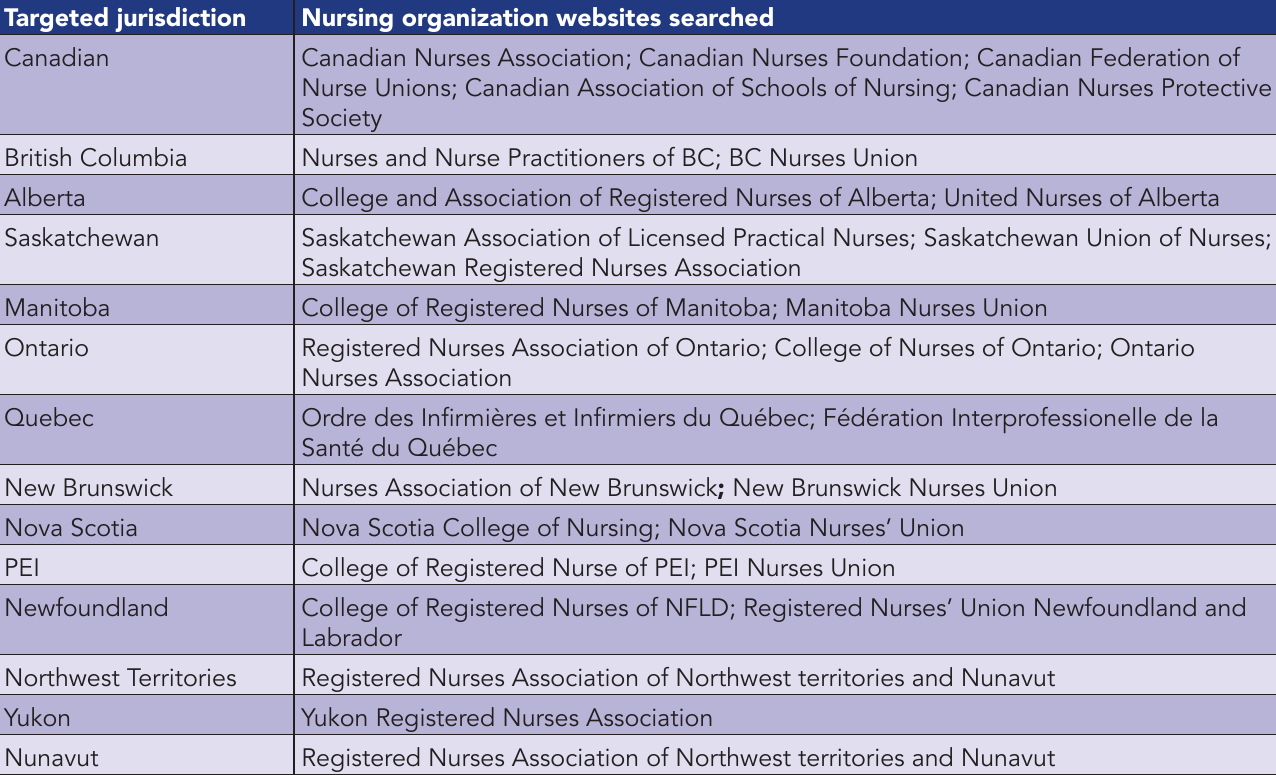
Table 6: List of Canadian Nursing Organizations whose websites were searched for recommendations for the jurisdictional